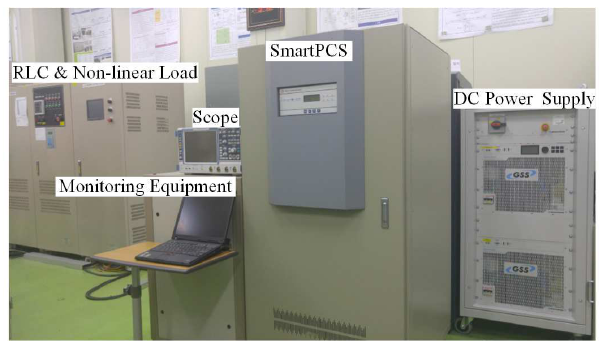
Figure 11. Experimental setup.